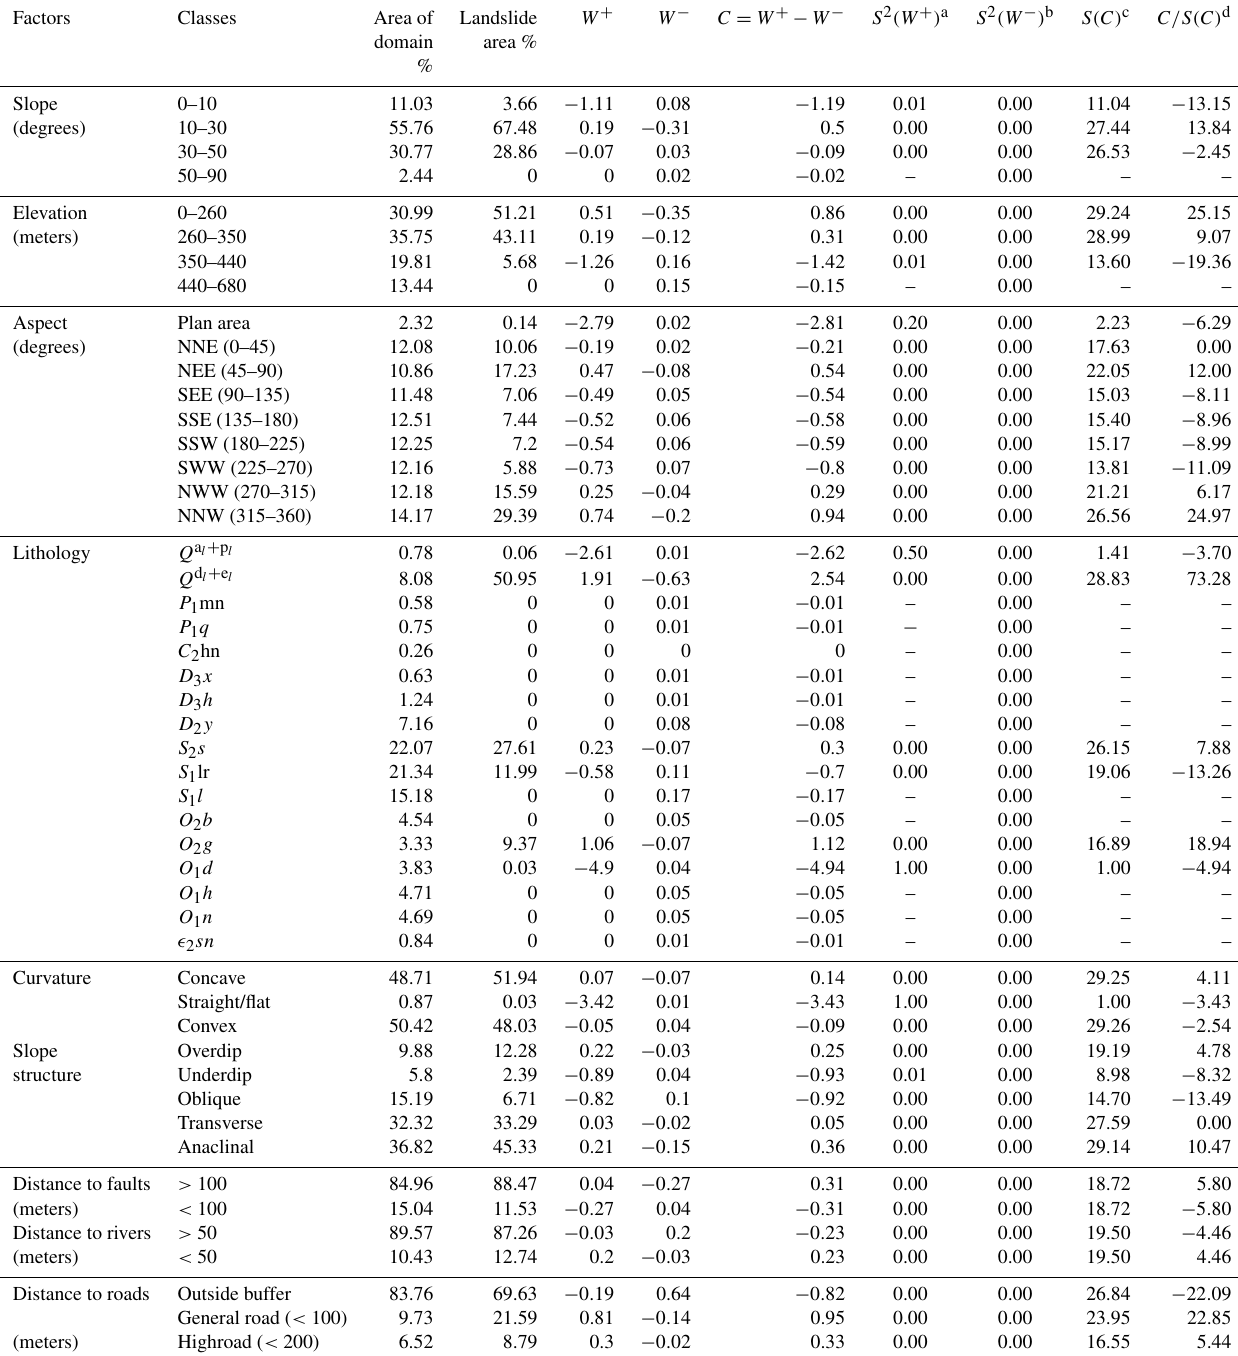
Table 5. The weight and contrast values by the weight-of-evidence model for landslide susceptibility mapping of Yuyangguan, western Hubei,